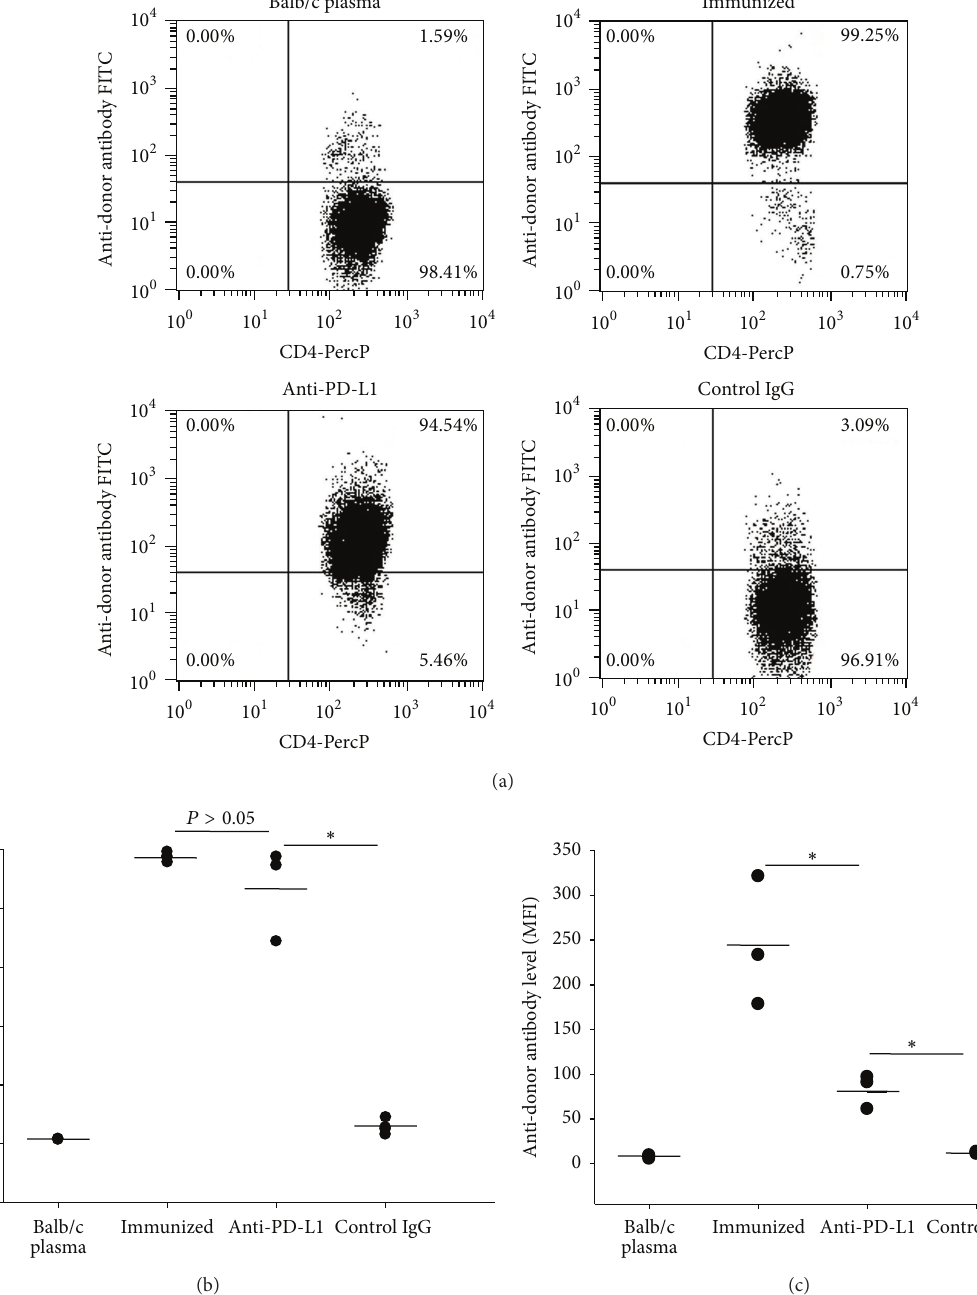
Figure5:Anti-mousePD-L1antibodytreatmentpartiallyrecoversthedevelopmentofantibodiesagainstalloantigensinC3Hmicewithlong- lasting tolerance to Balb/c alloantigens. Tolerant C3H mice 6 weeks after tolerance induction were given alloantigen challenge by injection of Balb/c spleen cells (2 × 10 5 /mouse) along with anti-mouse PD-L1 mAb (100 𝜇 g/mouse) or control IgG (100 𝜇 g/mouse) once a week for two weeks. The following week, plasma samples were prepared from all mice, and the levels of anti-donor (Balb/c) antibodies were examined as described elsewhere. The plasma samples from the Balb/c and na¨ıve C3H mice immunized by Balb/c spleen cells served as controls. We only gated CD4+ T cells to analyze anti-donor antibody levels to eliminate false positivity caused by B cell IgG Fc binding. (a) A representative mouse of each group was exhibited. (b) The summary of 3 mice in each group was depicted. Data represent mean ± standard error. ∗ 𝑃 < 0.05 . 𝑃 values were calculated using one-way